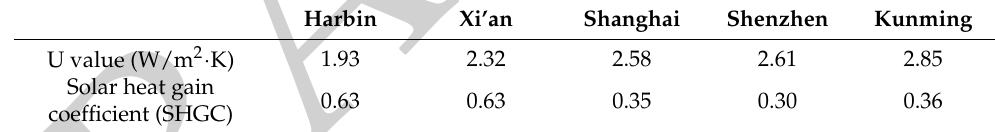
Table 6. The wall parameter setting in the five climate Construction of the Exterior Wall